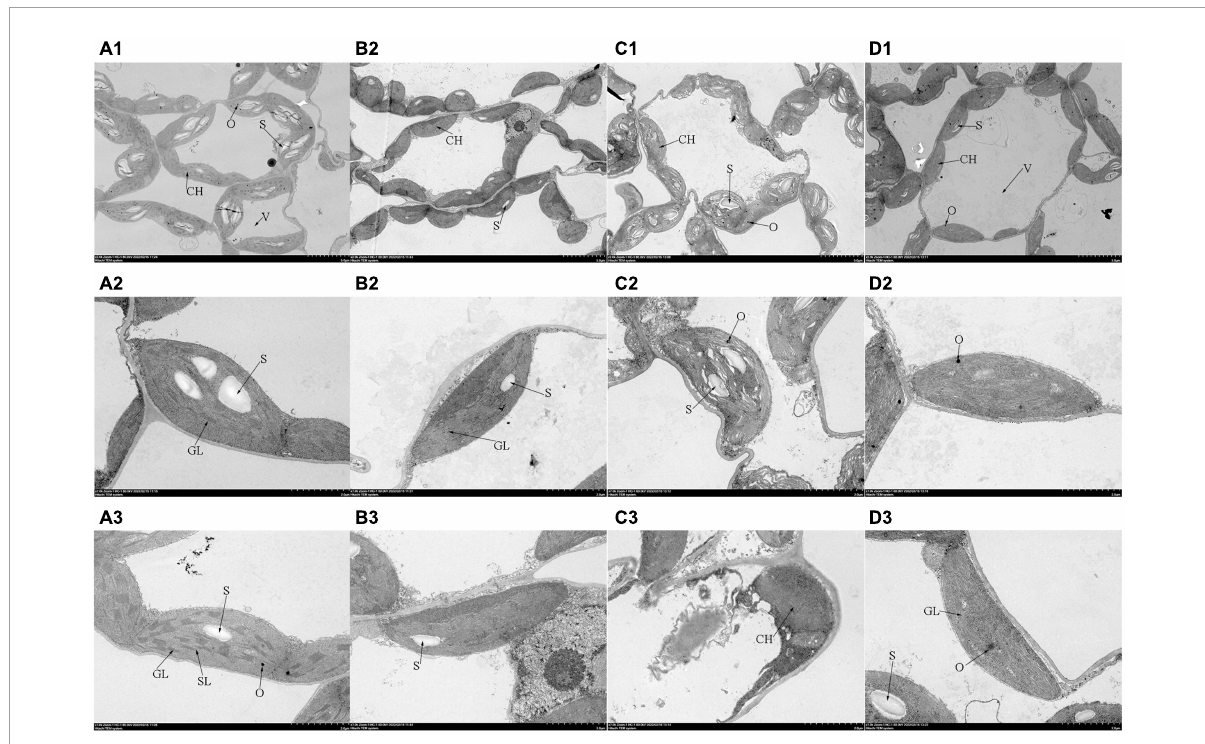
FIGURE4 Effects of Tre treatment on the chloroplast ultrastructure of tomato seedlings exposed to salt stress for 5 days. Panels (A–D) represent the chloroplast ultrastructure of tomato leaves in CK, T, S, and S+T, respectively. (A1–D1) × 2,000, scale bars = 5 µ m; (A2–D3) × 7,000, scale bars = 2 µ m. CH, chloroplast; V, vacuole; GL, grana lamellae; SL, stroma lamellae; S, starch grains; O, osmiophilic